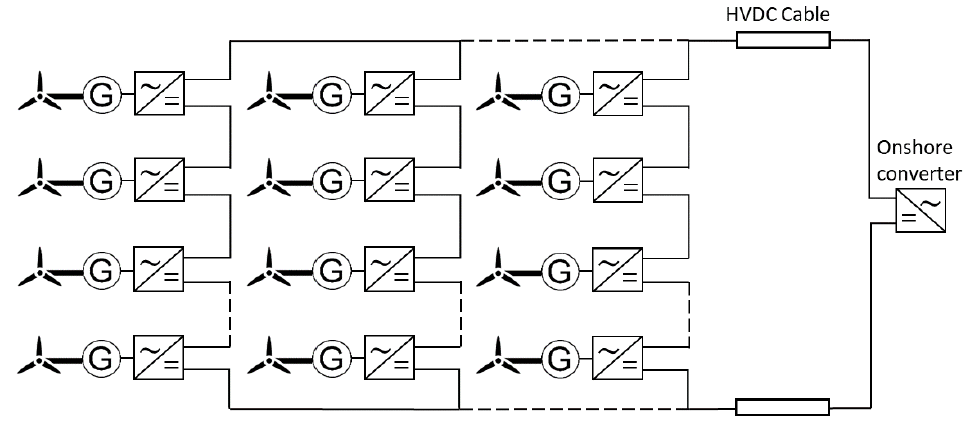
Figure 8. DC collection system with series-parallel-connected WTs.